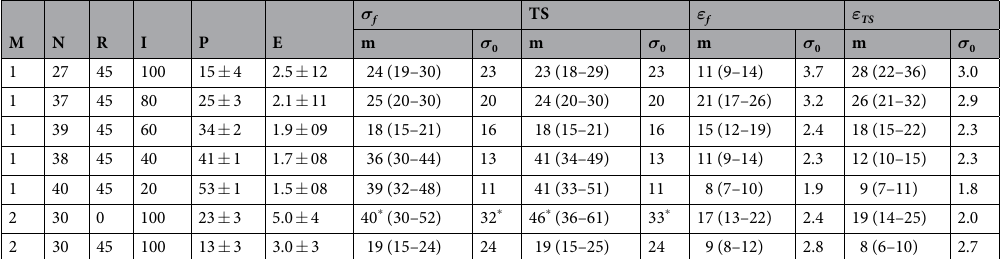
Table 1. Summary of mechanical properties for material 1 and 2 (M) with sample size N that are build in raster orientation (R, 45 = − 45/45°, 0 = 0°) with an infill (I, %) and porosity (P, vol.%). E is the elastic modulus in GPa. Weibull modulus (m) and scale parameter ( σ 0 ) of the fits to fracture stress ( σ f ), tensile strength (TS), nominal strain at break ( ε